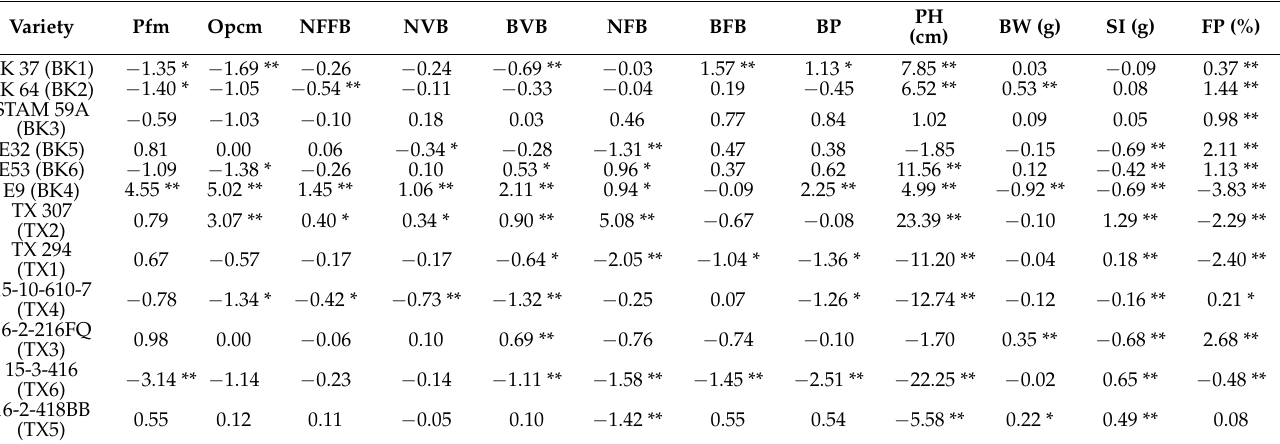
Table 3. General combining ability (GCA) of 12 ˆ cotton lines originated from Burkina Faso and the United